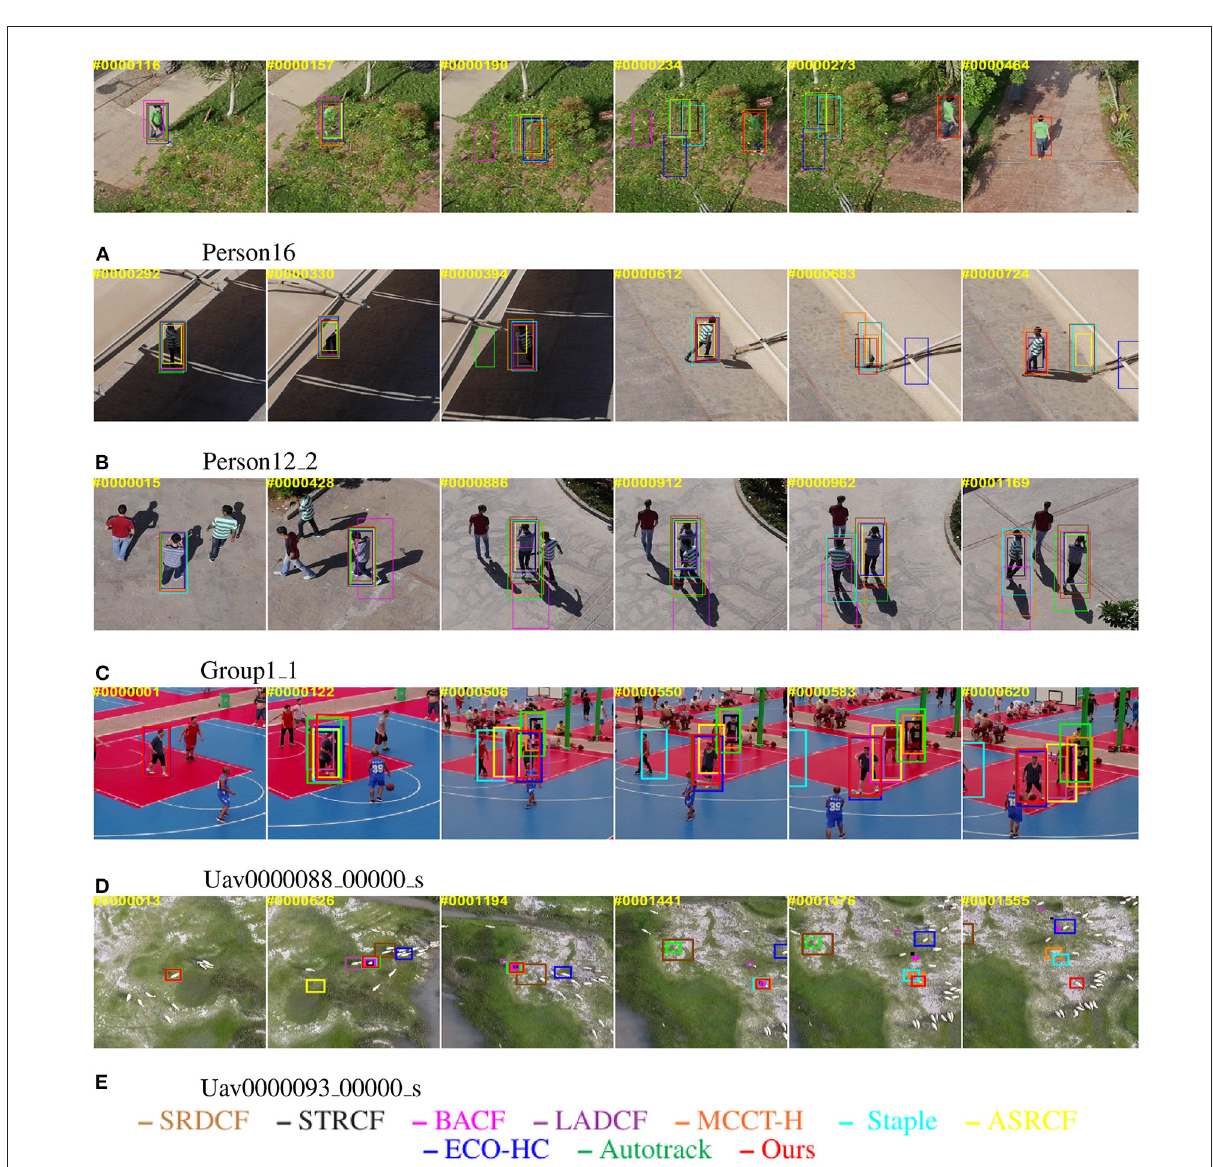
FIGURE3 Qualitative performance evaluation of the proposed tracker and the other nine most advanced trackers on the typical UAV videos. The number in the upper left corner refers to the frame number. The tracking boxes in different colors represent the tracking results of different trackers in the frame. (A) Person16. (B) Person12_2. (C) Group1_1. (D) Uav0000088_00000_s. (E) Uav0000093_00000_s. The photos appearing in this figure have been reused from: ‘A benchmark and simulator for uav tracking’ and ‘Vision meets drones: a challenge’. The corresponding website are ‘https://cemse.kaust.edu.sa/ivul/uav123’ and